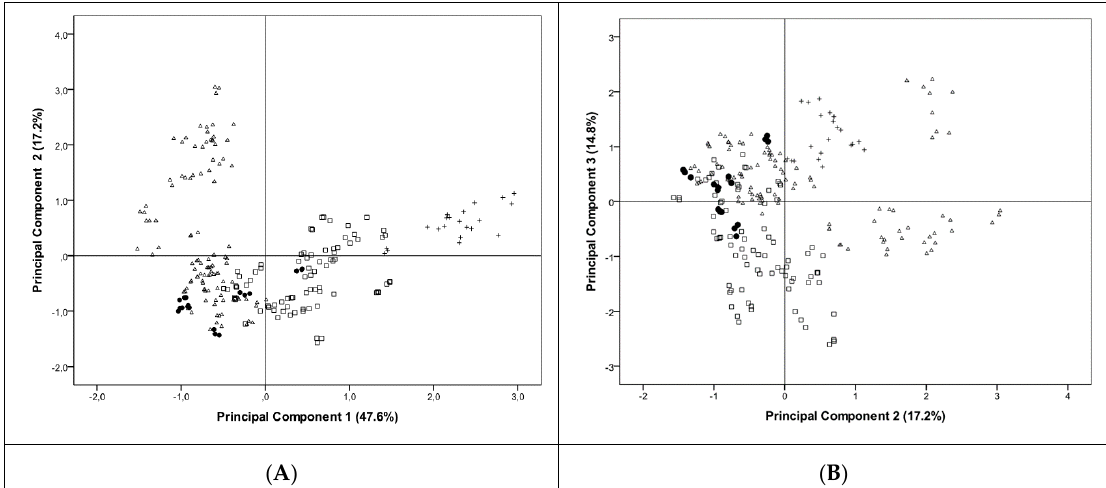
Figure 2. Principal component (PC) analysis applied to the four types of bread studied ( Δ —wheat; □ —maize; ● —maize/wheat; +—maize/rye) based on Mg, Ca, K, P, Cu, Fe, Mn, and Zn: ( A ) PC1 vs. PC2 and ( B ) PC2 vs. PC3.